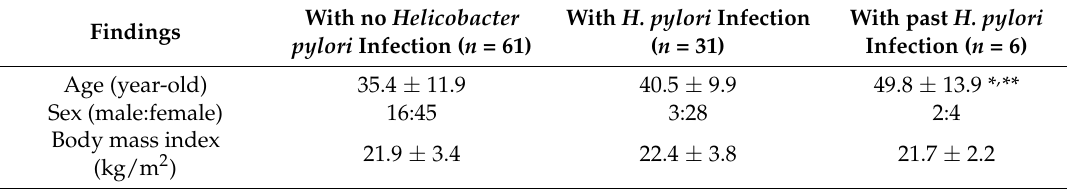
Antrum: 16S ribosomal RNA (rRNA) sequencing analysis